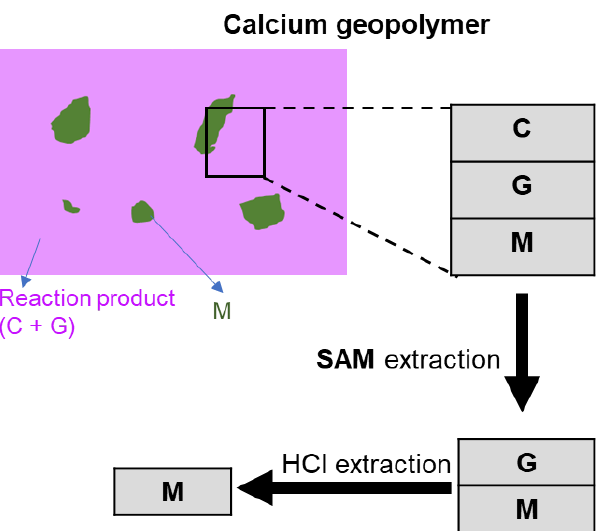
Figure 1. Flowchart of salicylic acid / methanol (SAM) and hydrochloric acid (HCl) extractions to selectively remove calcium silicate hydrate (C) and geopolymer gel (G) from calcium geopolymer that contains C, G and metakaolin (M).